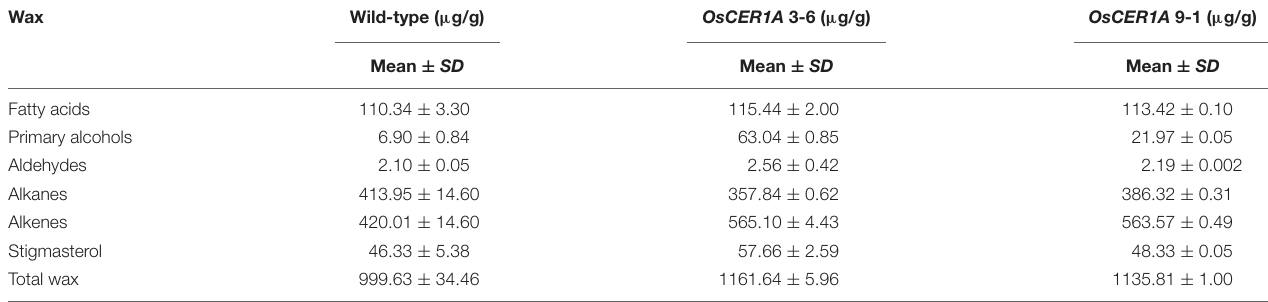
TABLE 1 | Epicuticular wax composition of anthers from WT and OsCER1A